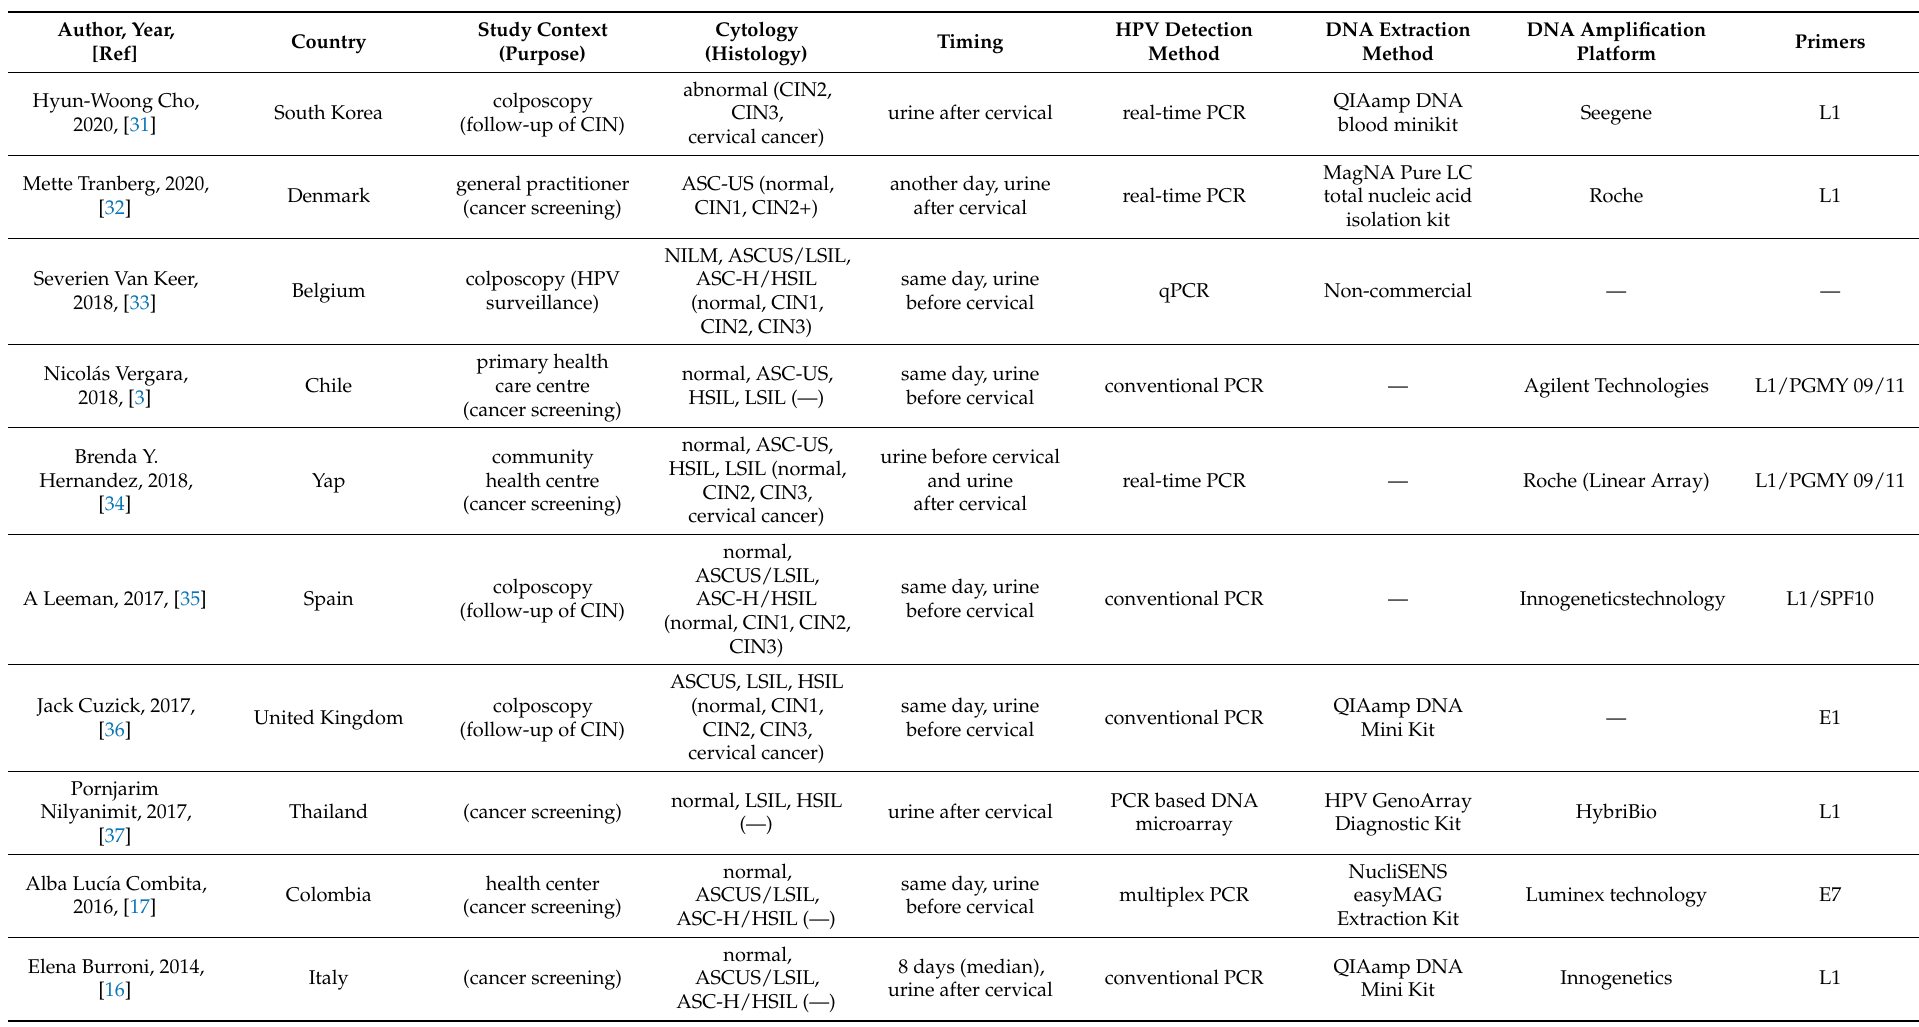
Table 1. Qualitative characteristics of included